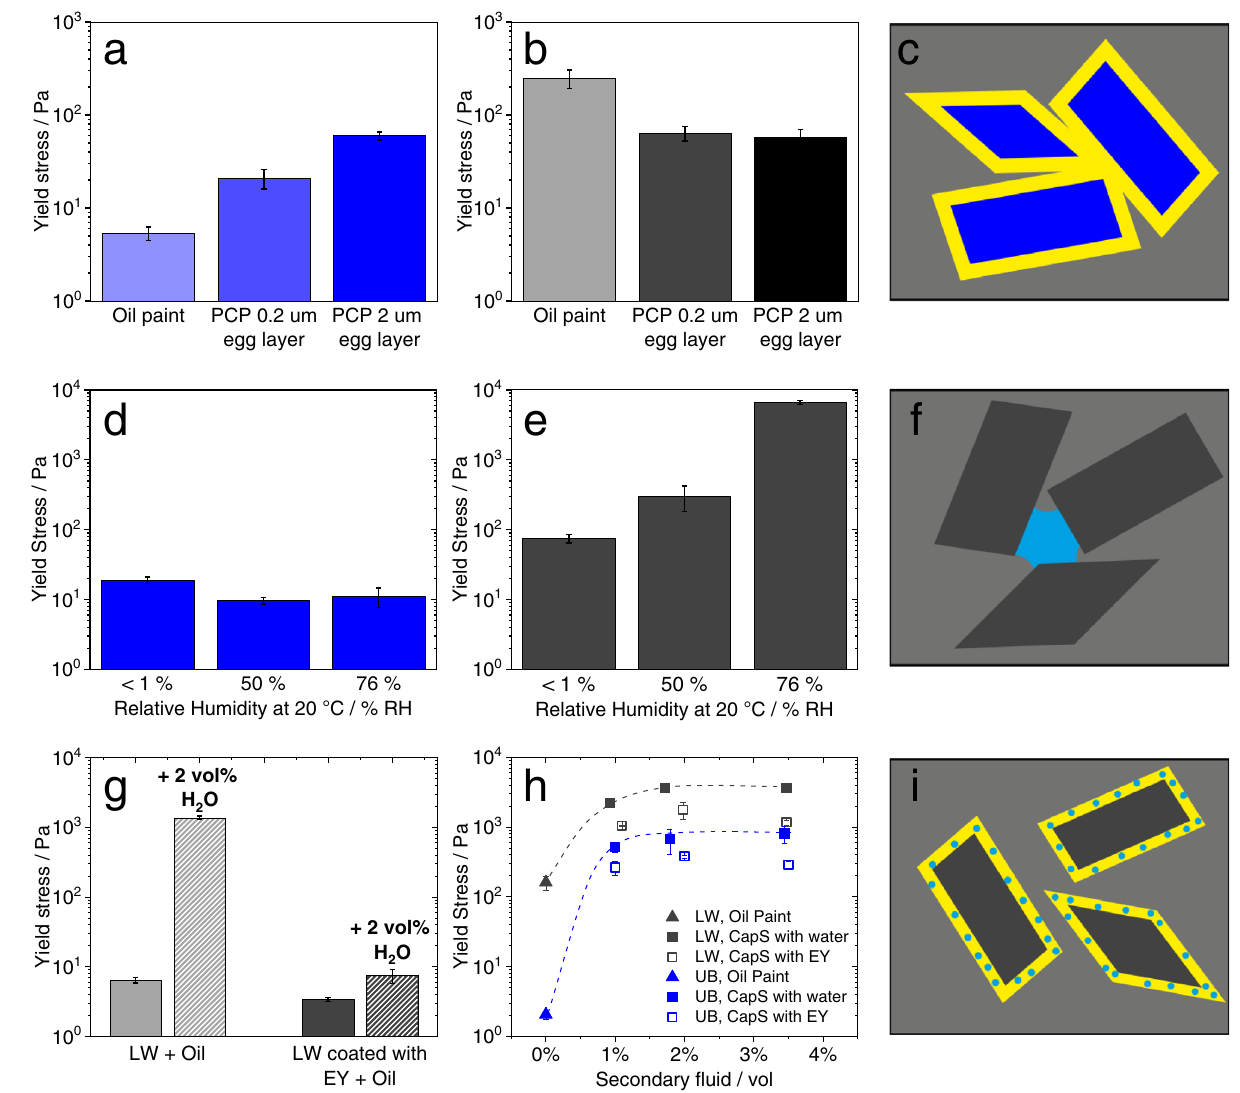
Fig. 4 | In fl uence of proteinaceous coating and humidity on yield stress and microstructure. Ultramarineblue(UB)paintsaredisplayedinblue,andleadwhite (LW) paints in black. a , b Yield stresses of paints prepared at a solids fraction of φ =32vol% with or without an egg yolk (EY) coating, dispersed in linseed oil. The pigmentswerestoredatarelativehumidityof ≈ 50RH%priortobedispersedinoil. ThethicknessoftheEYlayerwascalculatedfromtheEYdrymatterusedtoprepare the protein-coated pigments (PCP) assuming ideal monodisperse spherical parti- clesandwasincludedwhencalculating φ forthePCPpaints. c representationofthe steric attraction among pigment particles (in blue) due to the hydrophilic surface layers (in yellow), attempting to minimize the contact with oil molecules (in gray). d , e Yield stress of oil paints φ =32vol% prepared after a pigment storage of